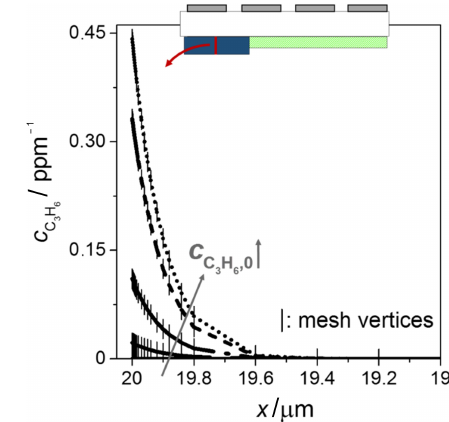
Figure 6. Measured (points) and simulated (lines) temperature dif- ference (cid:49)T between the catalytically activated and the inert part of the sensor when the propene feed gas concentrations and the over- all sensor temperature were varied (stationary conditions). The inset scheme illustrates at which points the temperature difference was